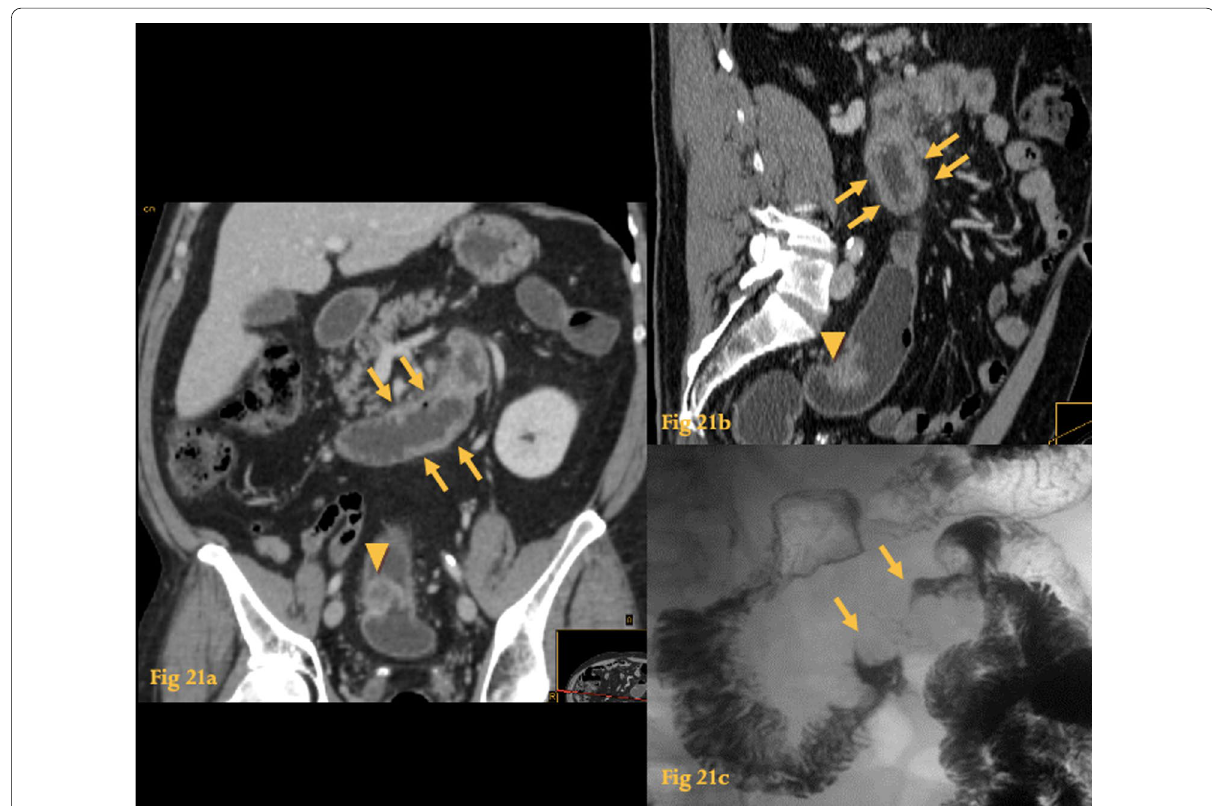
Fig. 21 Metastasis. Abdominal and pelvic CT ( a , b ) of a patient with sigmoid colon cancer, performed to stage the disease, clearly demonstrated the sigmoid tumor (arrowheads) but failed to show distant metastases. However, MPR and retrospective analysis revealed a discrete circumferential thickening on D3 and D4 (arrows) which was not recognized initially. This duodenal lesion progressed to become an “apple core” lesion (arrows) causing obstructive symptoms, as evaluated by a barium study performed 2 months later ( c